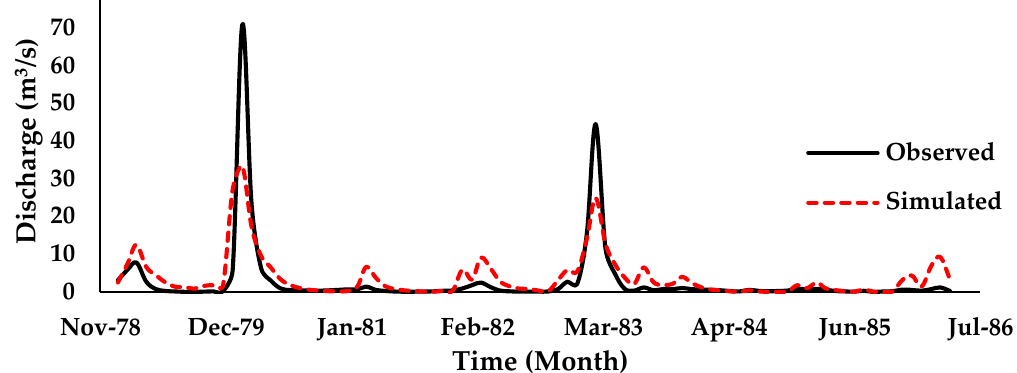
Figure 8. Simulated and observed monthly flow at Agua Caliente Gauging Station by using the SUFI-2 method.